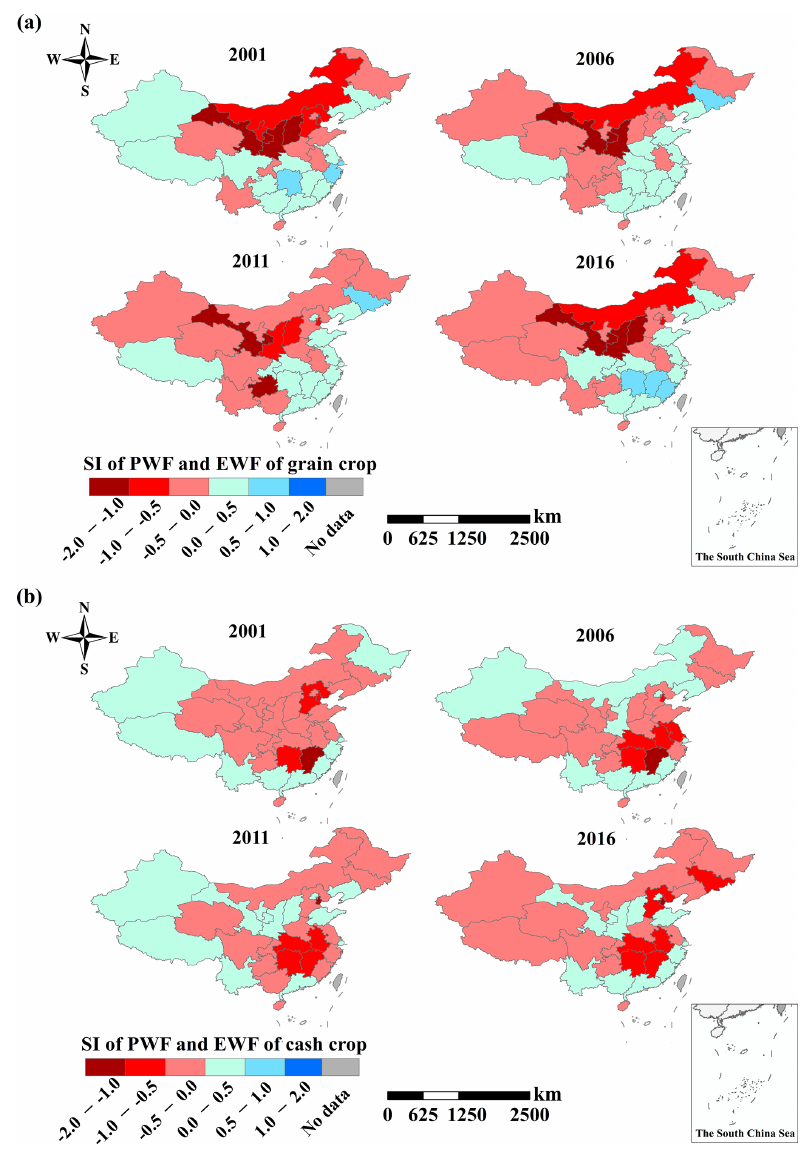
Figure 8. Temporal and spatial evolution of synergy evaluation index (SI) of (a) grain and (b) cash